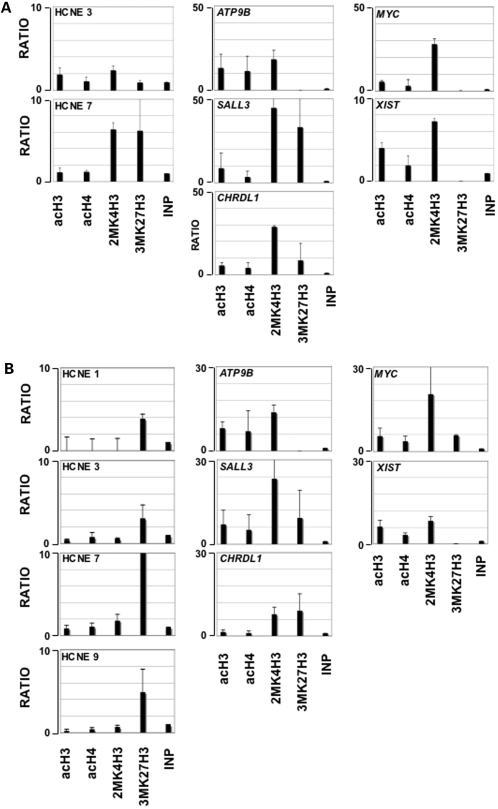
ChIP of the HCNE on total E11.5 chromatin and adult mouse brain.Embryonal (a) and adult brain chromatin preparations (b) were immunoprecipitated with the antibodies to the histone modifications indicated on the X axis and the DNA was PCR amplified with primers specific for each HCNE. INP: PCR from total chromatin. AcH3 and acH4: ChIP with antibodies to acetylated histone H3 or H4. 2MK4H3: ChIP with antibodies to 2-methyl K4 of histone H3; 3MK27H3: ChIP with antibodies to 3-methyl K27 of histone H3. All values are fold increases, compared to an equal amount of INP. Myc, Xist (positive controls), Atp9b, Sall3 and Chrdl1 indicate primers in the 5′UTR region of each gene. Only HCNEs positive for at least one modification were reported in the figure.